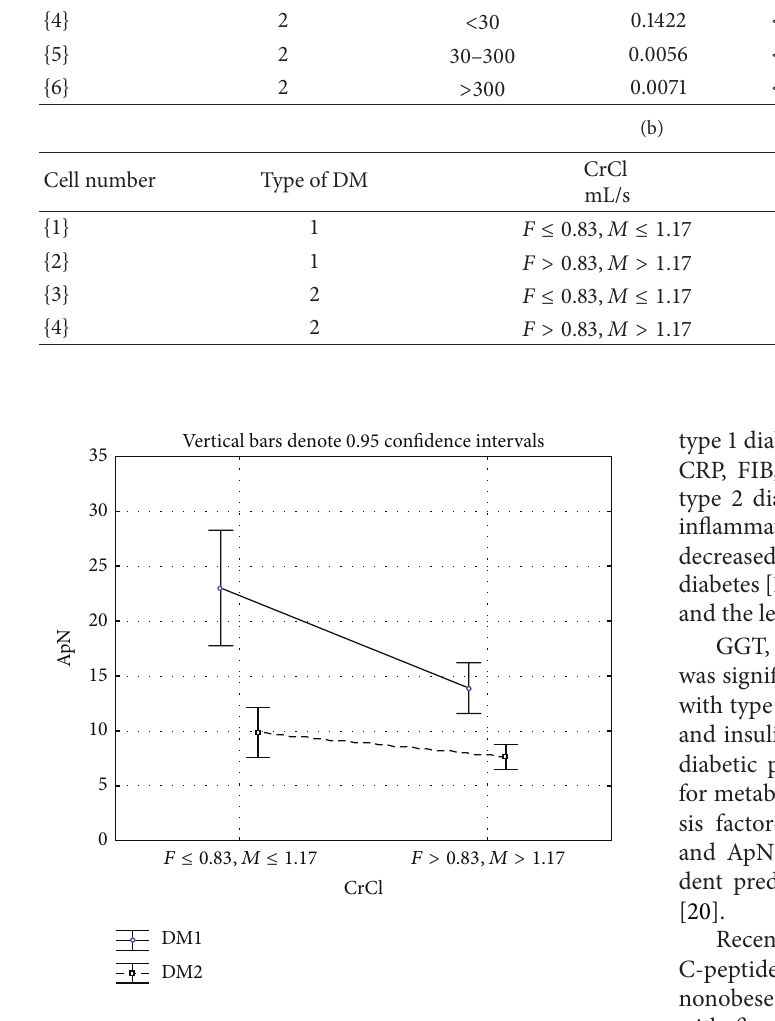
Figure2:ApNmeanvaluesand95%confidenceintervalsinpatients with type 1 and type 2 diabetes according to